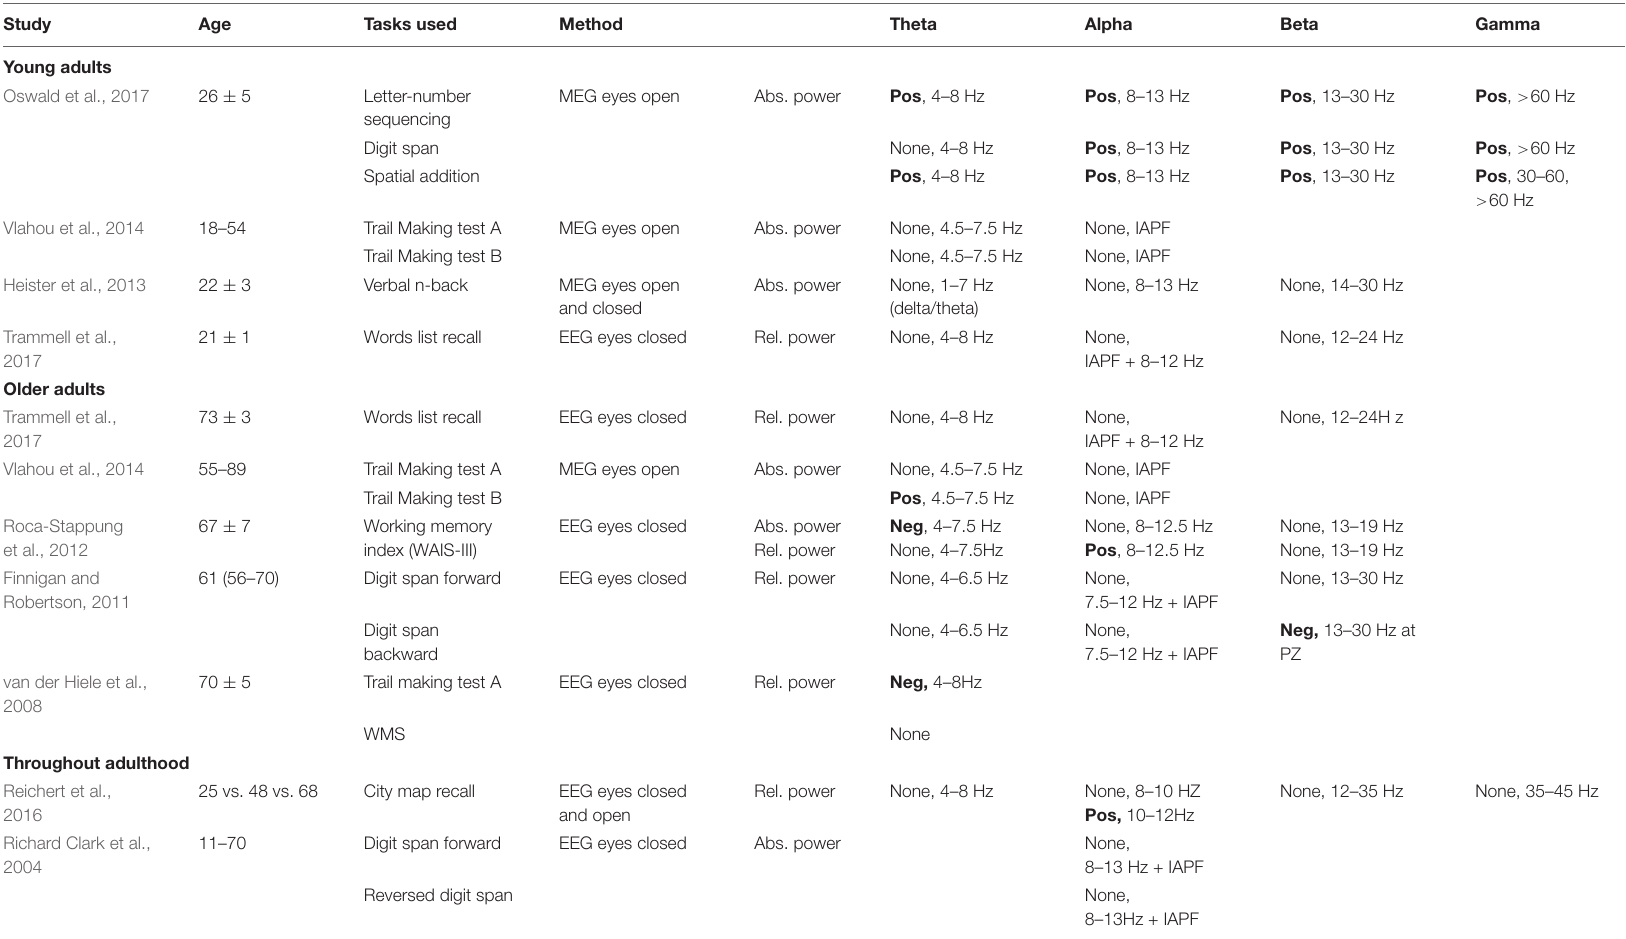
TABLE 1 | Studies reporting findings on the possible links between age-related changes in resting-state frequency bands activity and working memory performance: positive (Pos), negative (Neg) or no link (None).